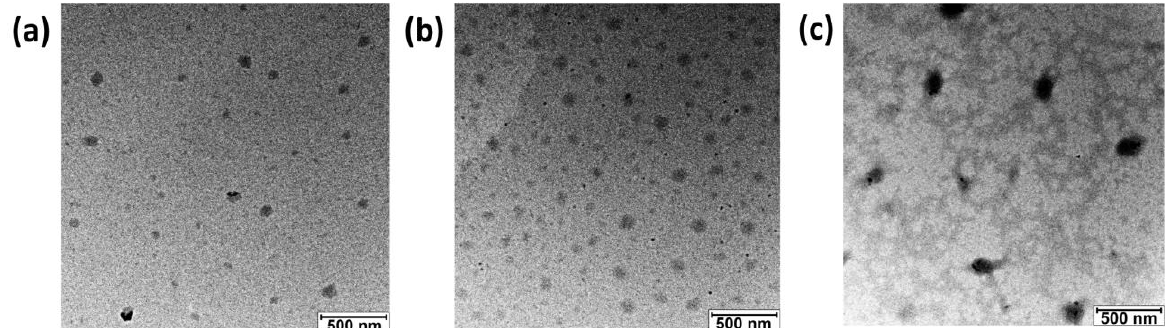
Figure 3. Characterization of polyzymes with encapsulated TMC species via TEM; ( a ) Au-Octo-PZ; ( b ) Au-XPhos-PZ; ( c ) Au-PPh 3 -PZ. Scale bar = 500 nm.